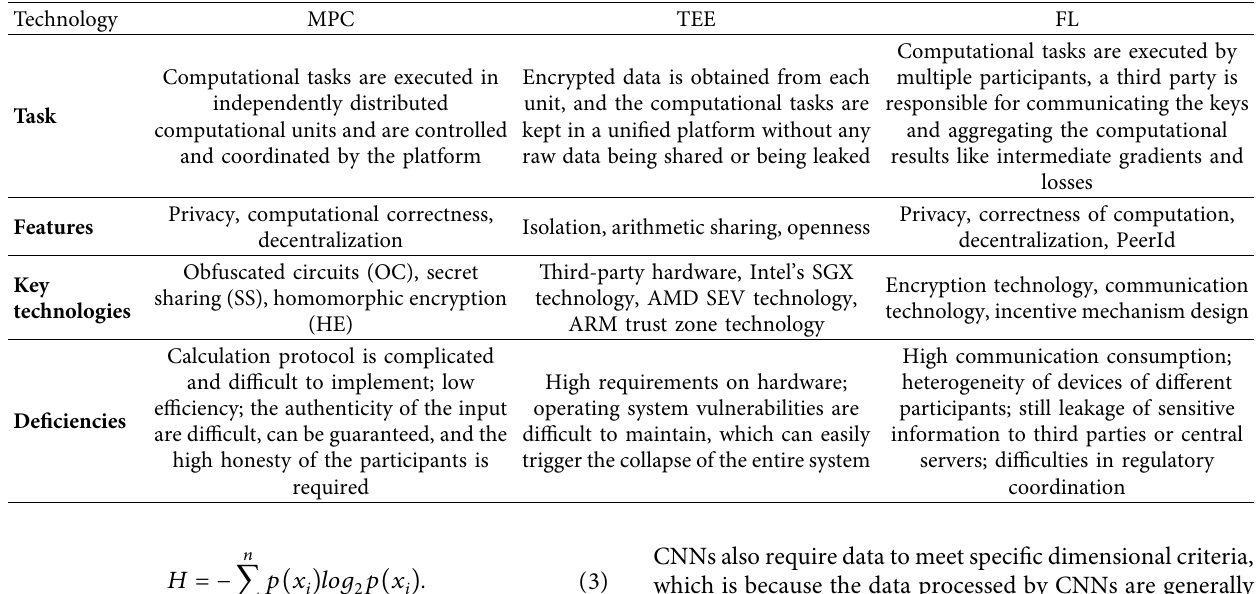
Table 3: Comparison of MPC, TEE and